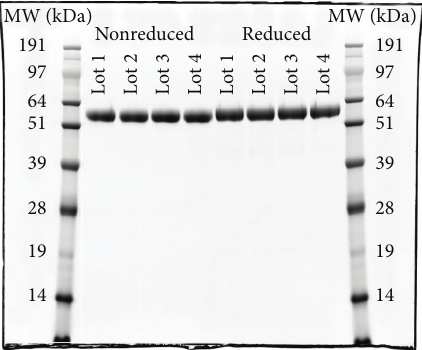
Figure 1: SDS-PAGE was performed using a NuPAGE 12% gel and 4x LDS sample buffer from Life Technologies (Grand Island, NY). Reduced lanes were treated with 𝛽 -mercaptoethanol to 5% of total sample volume. 2 𝜇 g of protein was loaded in each lane. Gels were stained with Coomassie Blue. Lanes are (from left to right), SeeBlue Plus 2 standard, lot 1, lot 2, lot 3, lot 4, lot 1 reduced, lot 2 reduced, lot 3 reduced, lot 4 reduced, and SeeBlue Plus 2 standard. Molecular weights corresponding to the standards are shown.